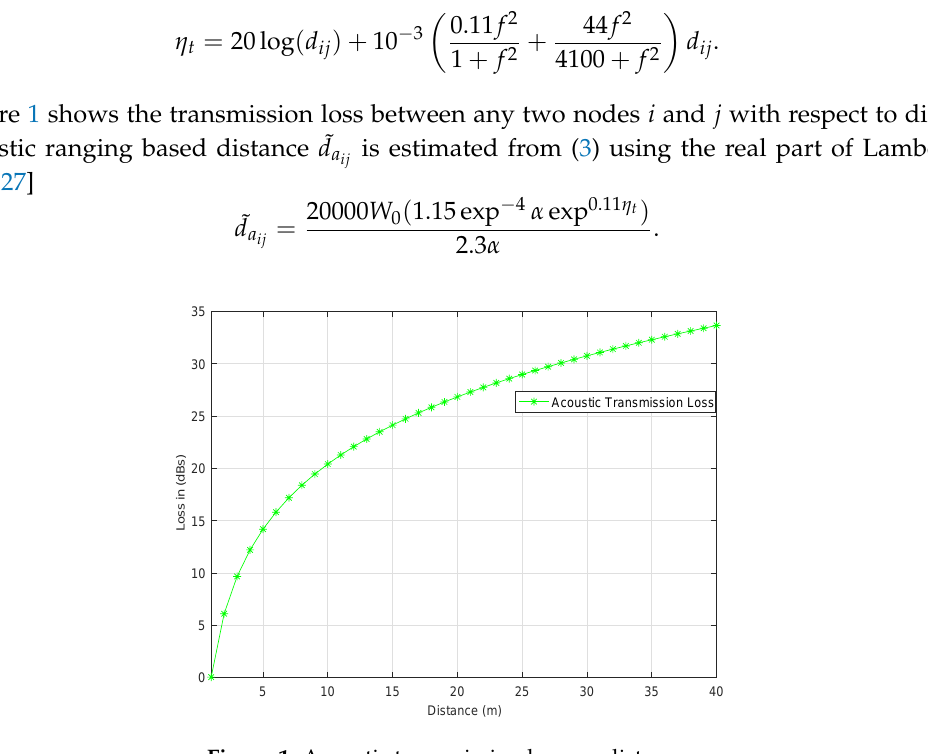
Figure 1. Acoustic transmission loss vs.